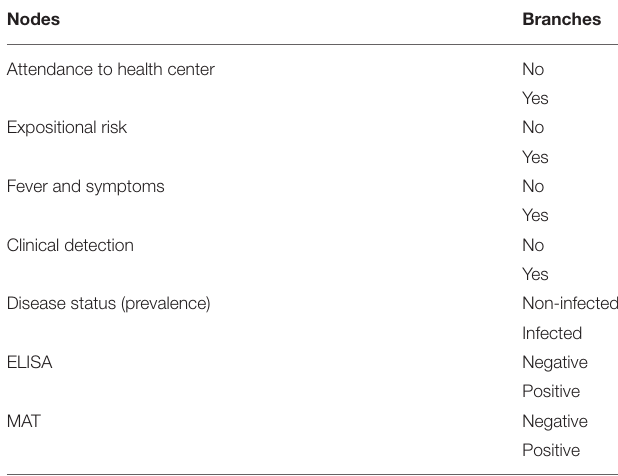
TABLE 1 | List of the current leptospirosis surveillance system component in Ecuador’s humans, from nodes and branches to be